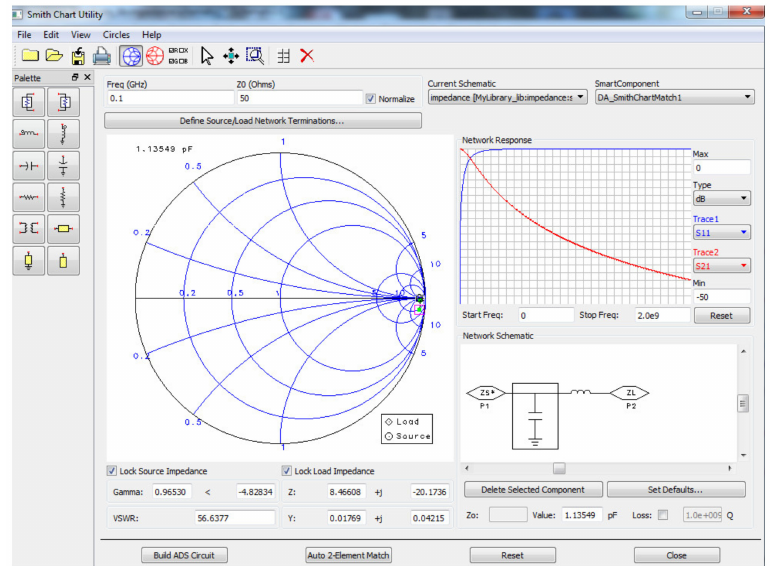
Figure 5. Smith chart utility for finding elements of the matching circuit.